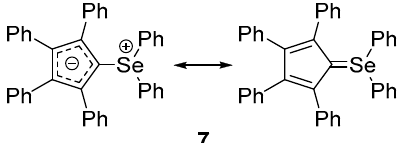
Figure 4. The first isolated selenonium ylide 7 .